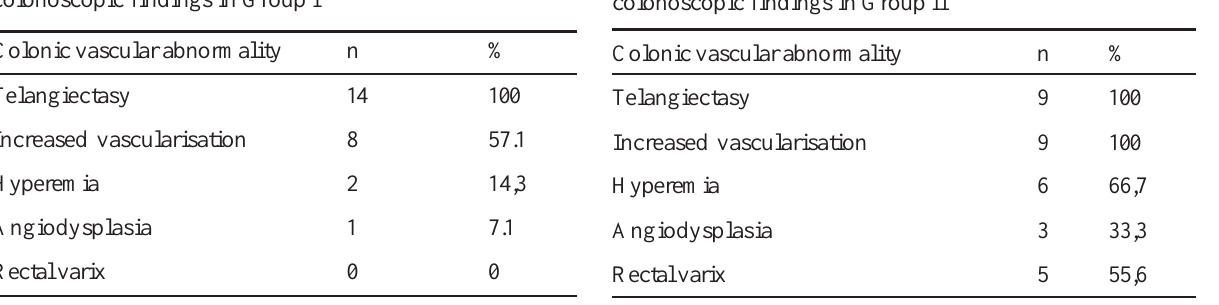
Chi squared for trend (pre-operative GII versus post- operative GI - χ 2 = 8.155 - p =